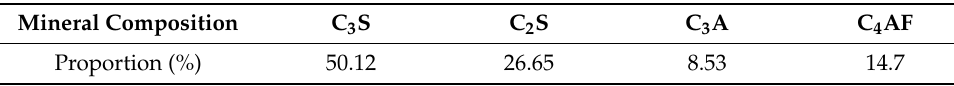
Table 6. Properties of the Portland cement.